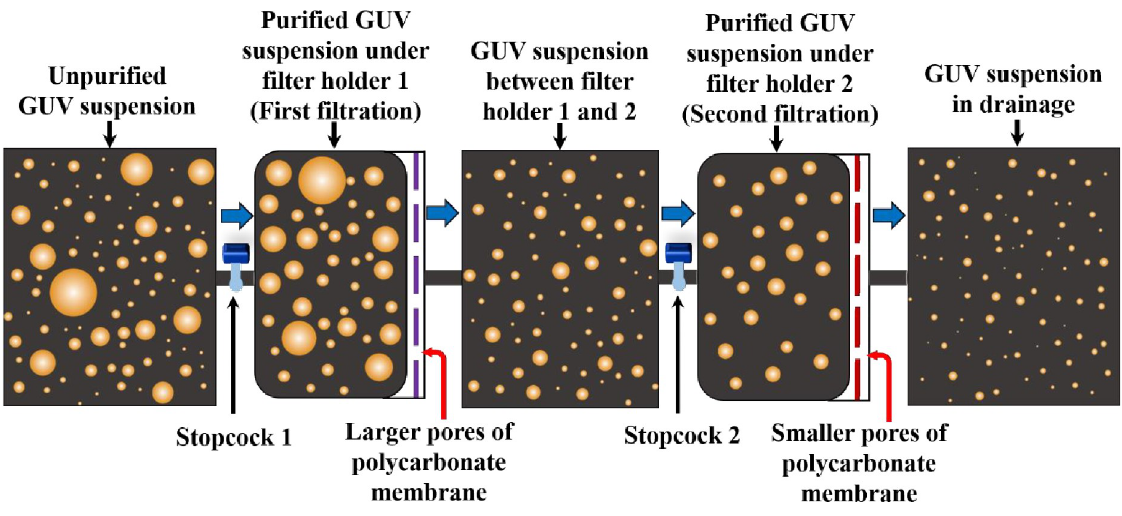
Fig 1. Schematic diagram of dual